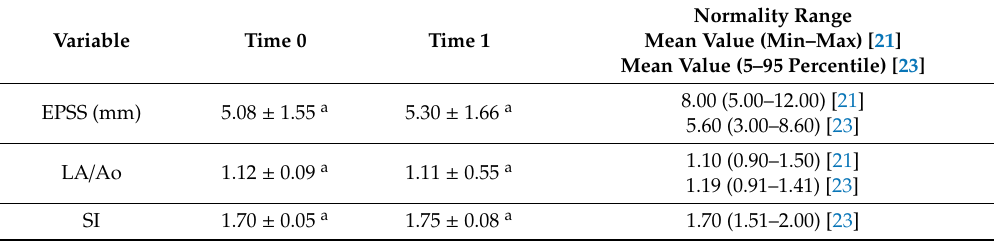
Table 4. Parameters that do not statistically change along pregnancy, expressed as mean ± SD at T0 and T1. The last column reports echocardiographic reference ranges of normality in Great Danes for each parameter considered (Koch et al. [21]; Stephenson et al.